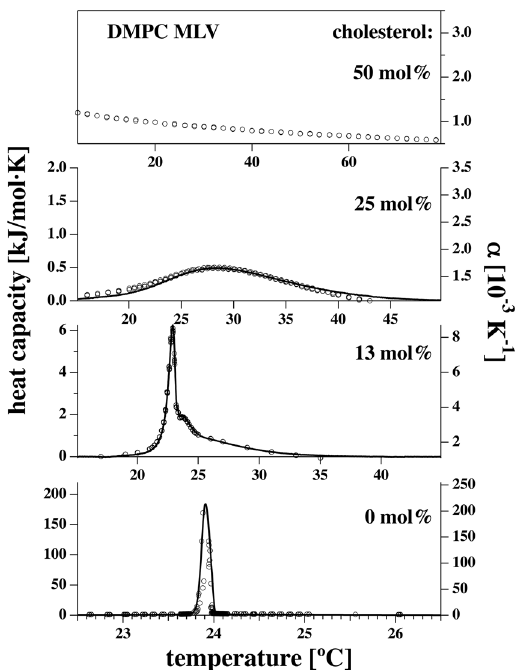
Figure 1. Excess heat capacity profiles Δ c p (solid lines) and volume expansion coefficients α V (open circles) for DMPC MLVs in the presence of 0 mol%, 13 mol%, 25 mol% and 50 mol% cholesterol (from bottom to top). For 50 mol%, the melting profile was so much broadened that no heat capacity anomaly could be identified. The volume expansion coefficient does not display an anomaly, either. The α V values were corrected for the baseline of pure water but plotted without subtracting the value of the volume expansion outside of the phase transition.